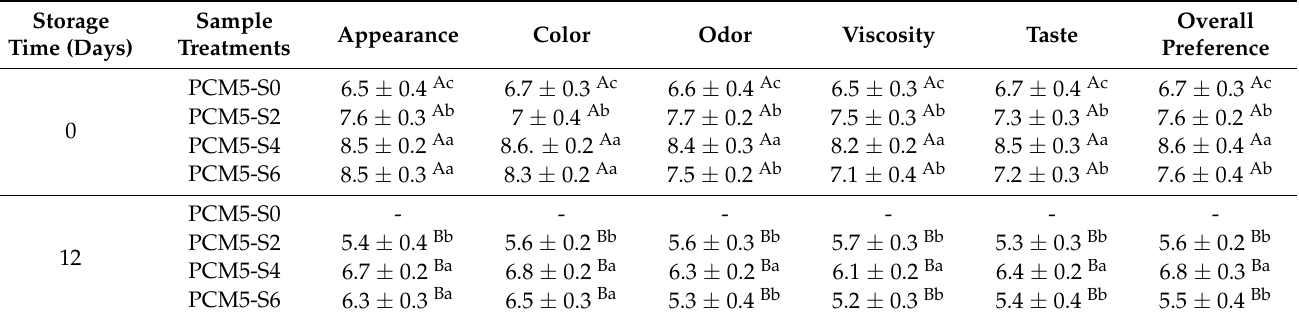
Table 3. Sensory evaluation of thermally processed PCM fortified with sucrose during storage at 4 ◦